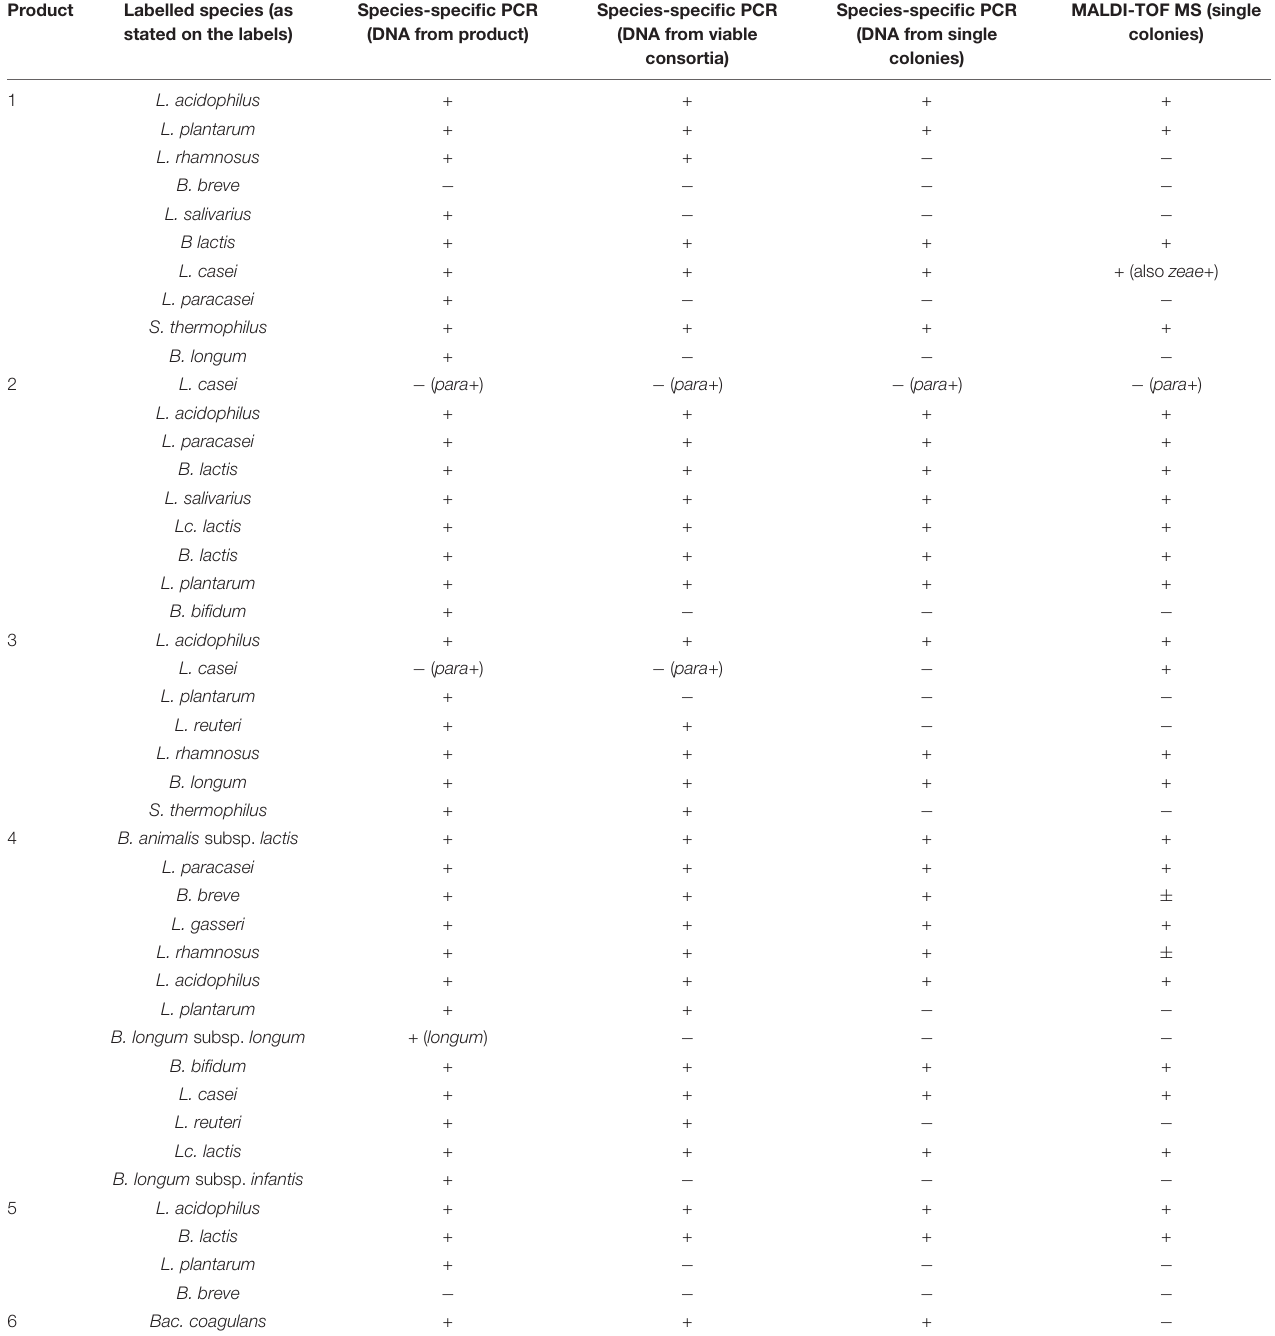
TABLE 1 | Results of the assessment of the presence of labelled species or subspecies in 17 dietary supplements for adults (A1–A17) and of 9 dietary supplements for children (C1–C9) by PCR using DNA isolated from products and from viable consortia (colonies) and by MALDI-TOF MS analysis of individual colonies (three per labelled